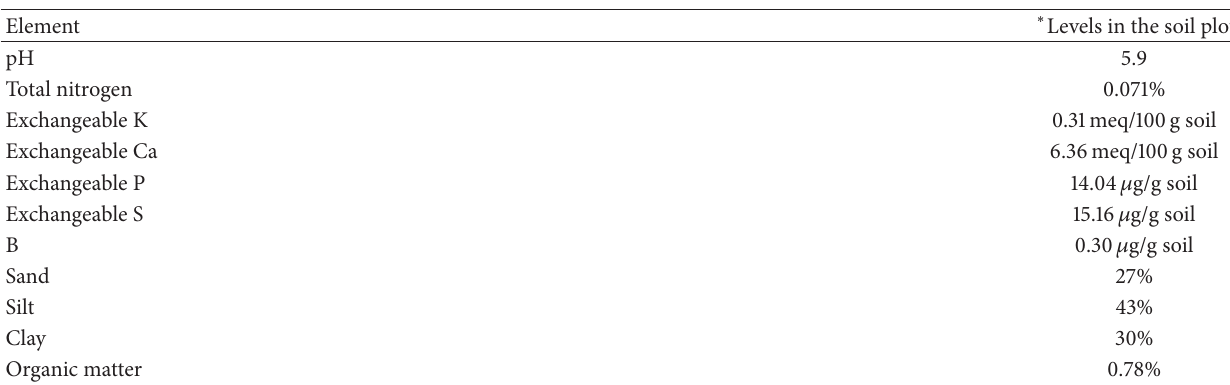
Table 1: (a) Soil test results of the experimental filed (mean of two years). (b) Monthly record of air temperature, relative humidity, and rainfall of the experimental site during the period of March to July 2014 and 2015 (mean of two